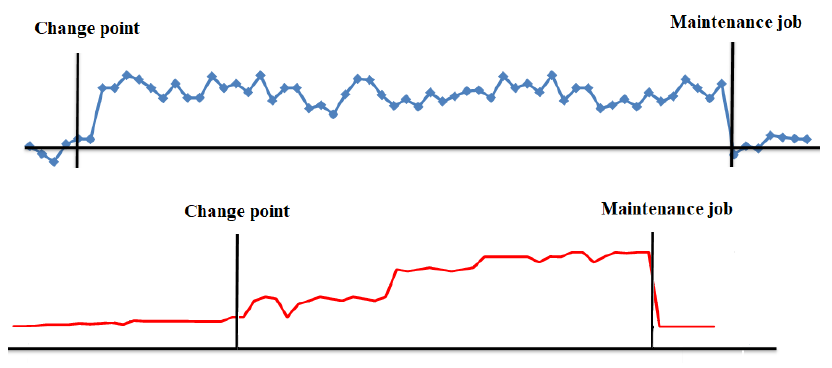
Figure 2. Change points in mini-terms. Proportional valve ( above ). Leak in cylinder ( below